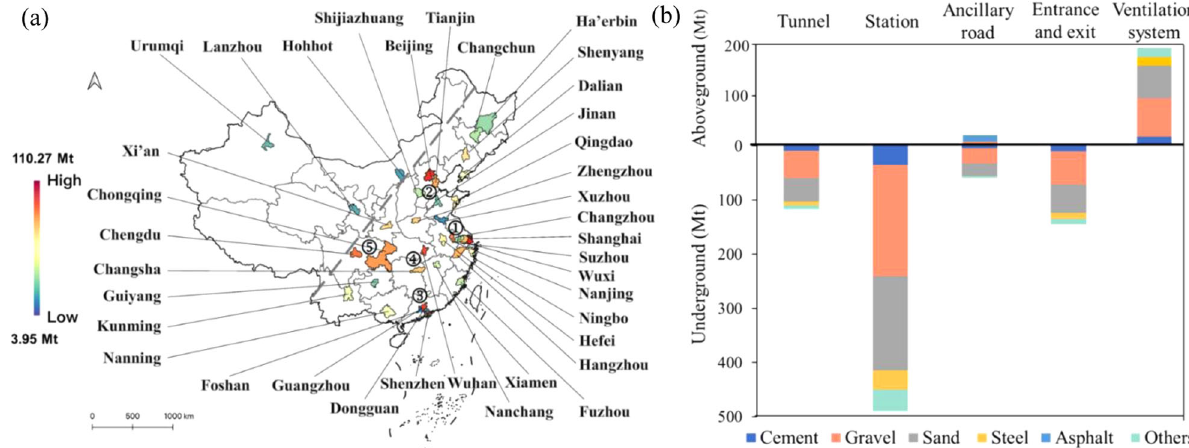
Fig. 5 The spatial characteristics of China ’ s subway material stocks. ( a ) Subway material stocks, geographical locations, and spatial boundaries of the 37 Chinese cities; and ( b ) The stock quantity and vertical distribution (above- and underground) by construction material and by component. Note: The fi ve major urban agglomerations in a are ① Yangtze River Delta, ② Jing-Jin-Ji Metropolitan Region, ③ Pearl River Delta, ④ Middle Yangtze Plain, and ⑤ Cheng-Yu Metropolitan Region; the gray dashed line is the Hu